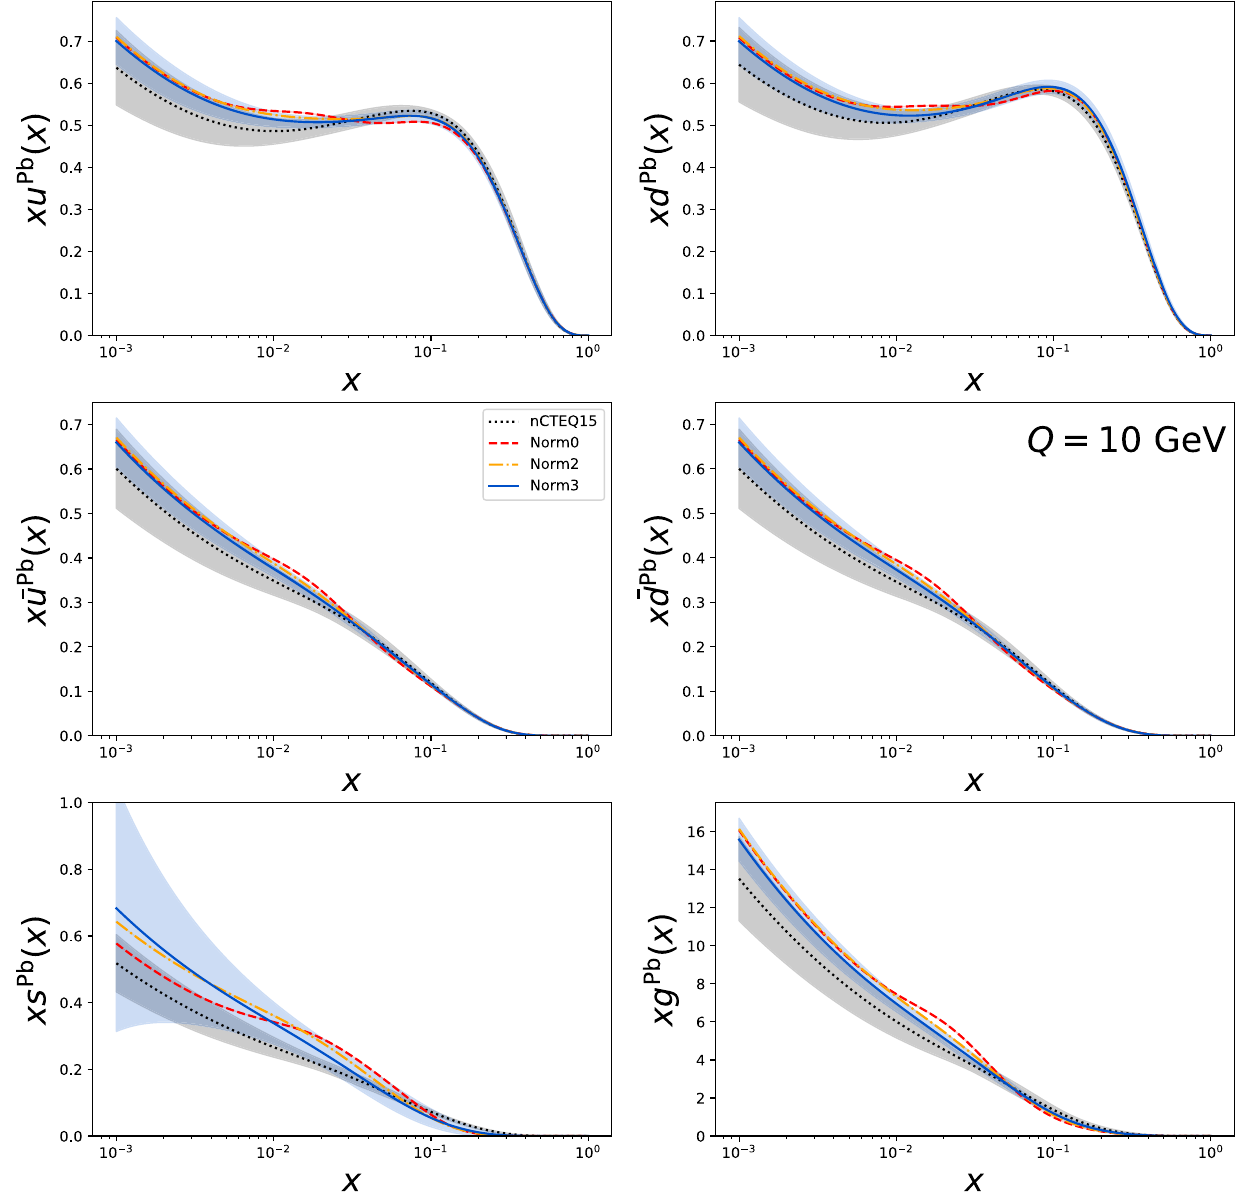
Fig. 8 The full lead (Pb) PDFs for Q = 10GeV. The uncertainty band for nCTEQ15 is shown in gray, and for Norm3 in blue. The increase in the Norm0 set for the strange and gluon PDFs is reduced, compared to the lower Q result, and shifted to smaller x ∼ 0 . 02 values